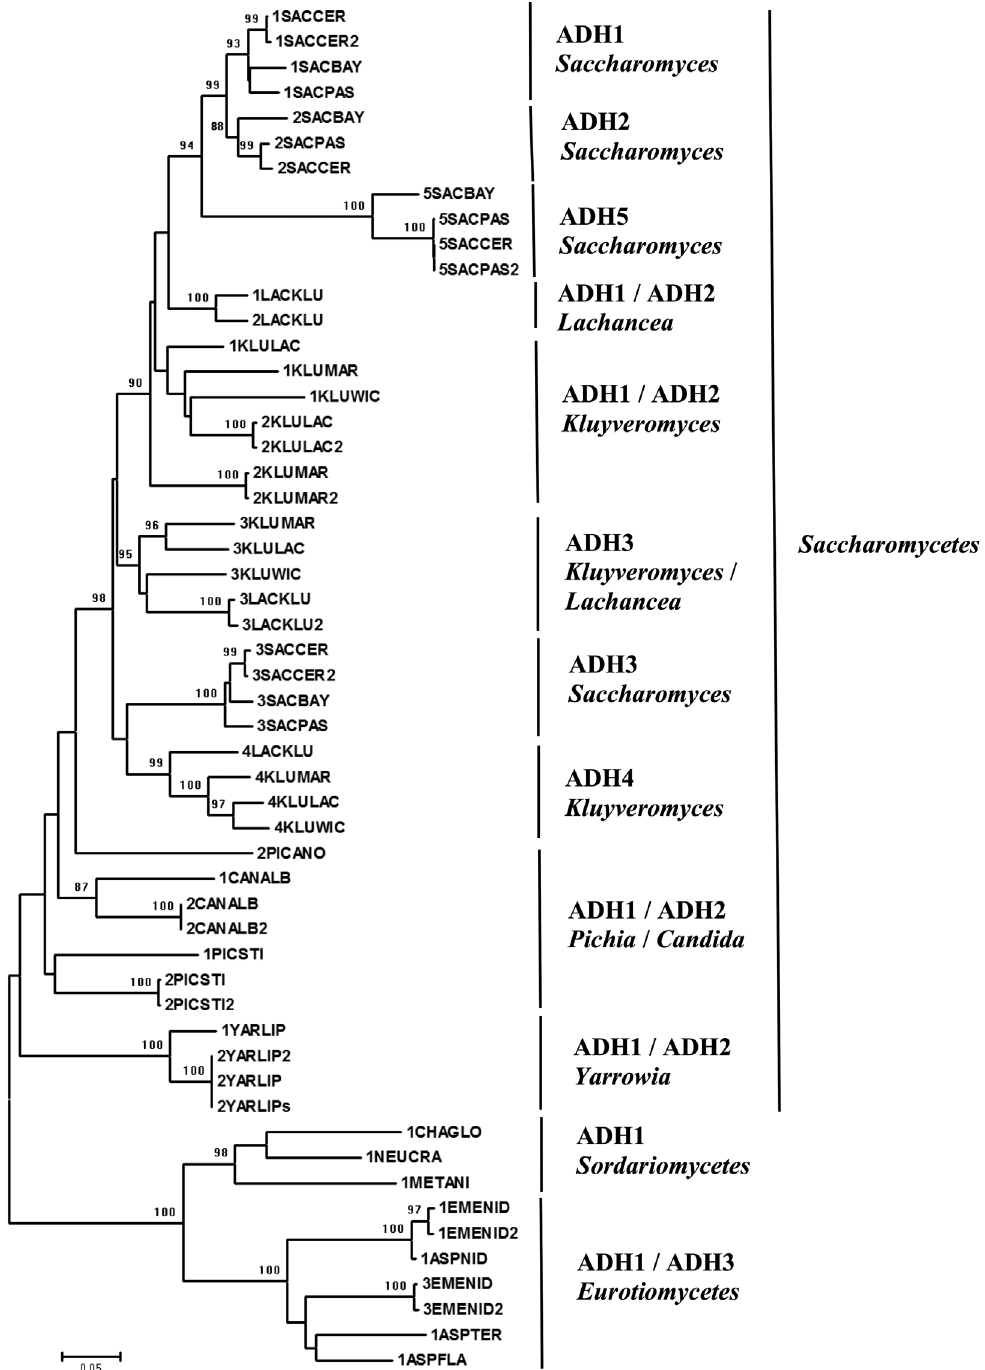
Figure 3 - Phylogenetic tree of alcohol dehydrogenase proteins from fungi obtained by the neighbor-joining algorithm. Labels are indicating clusters dis- tinguishable by ADH type and fungi genera. Numbers represent bootstrap values; values higher than 80% are shown. Scale bar indicates levels of se- quence